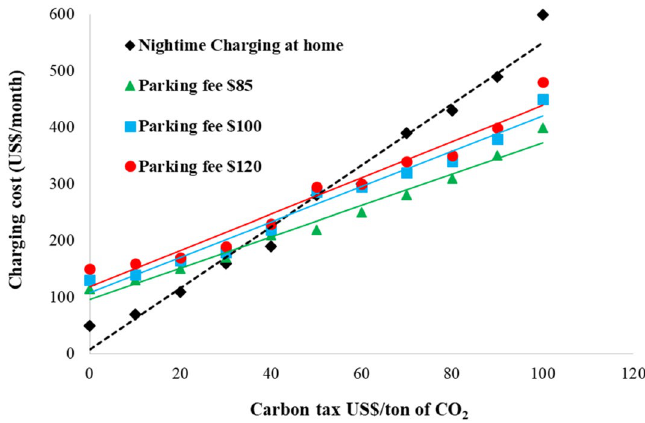
Figure 7. The effect of various carbon tax rates and parking fees on EV charging